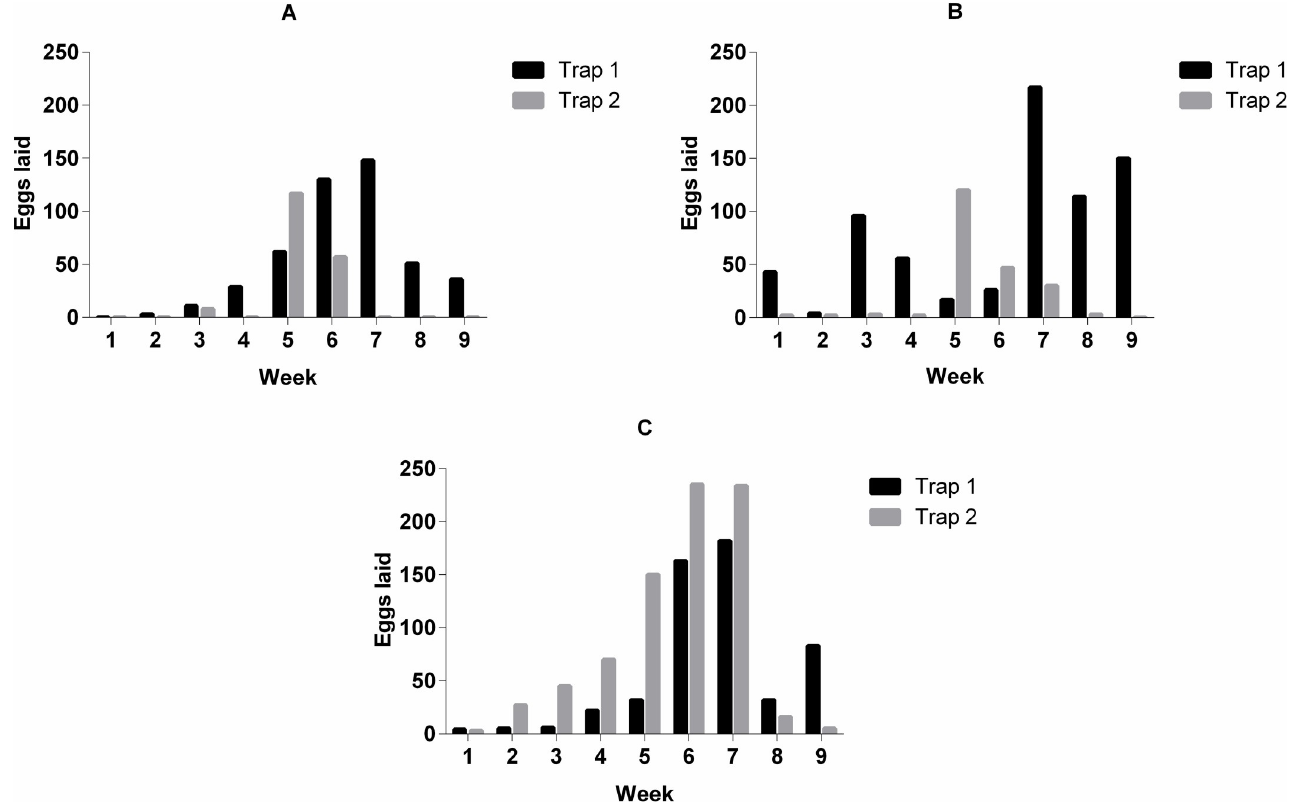
Fig 2. Effects of RHA on Aedes oviposition. Concentration of extract (RHA): 0.8 mg/mL. On the x-axis, there are the weeks of observation, and on the y-axis, the number of eggs laid by the Aedes females. A, B and C: Three points of high circulation of A . aegypti , at Universidade Estadual do Rio Grande do Norte, Mossoro´-RN, Brazil. Trap 1 only contained water throughout the experiment while trap 2 had water replaced by RHA after the seventh week of observation.